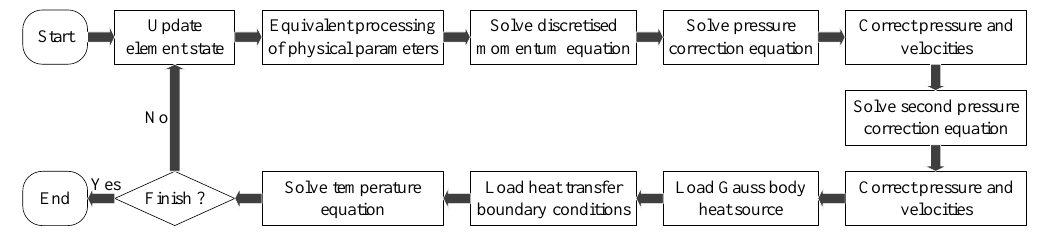
algorithm used SIMPLEC, and the time step was 1 ns. Figure 3 is the calculation flow chart for this study.